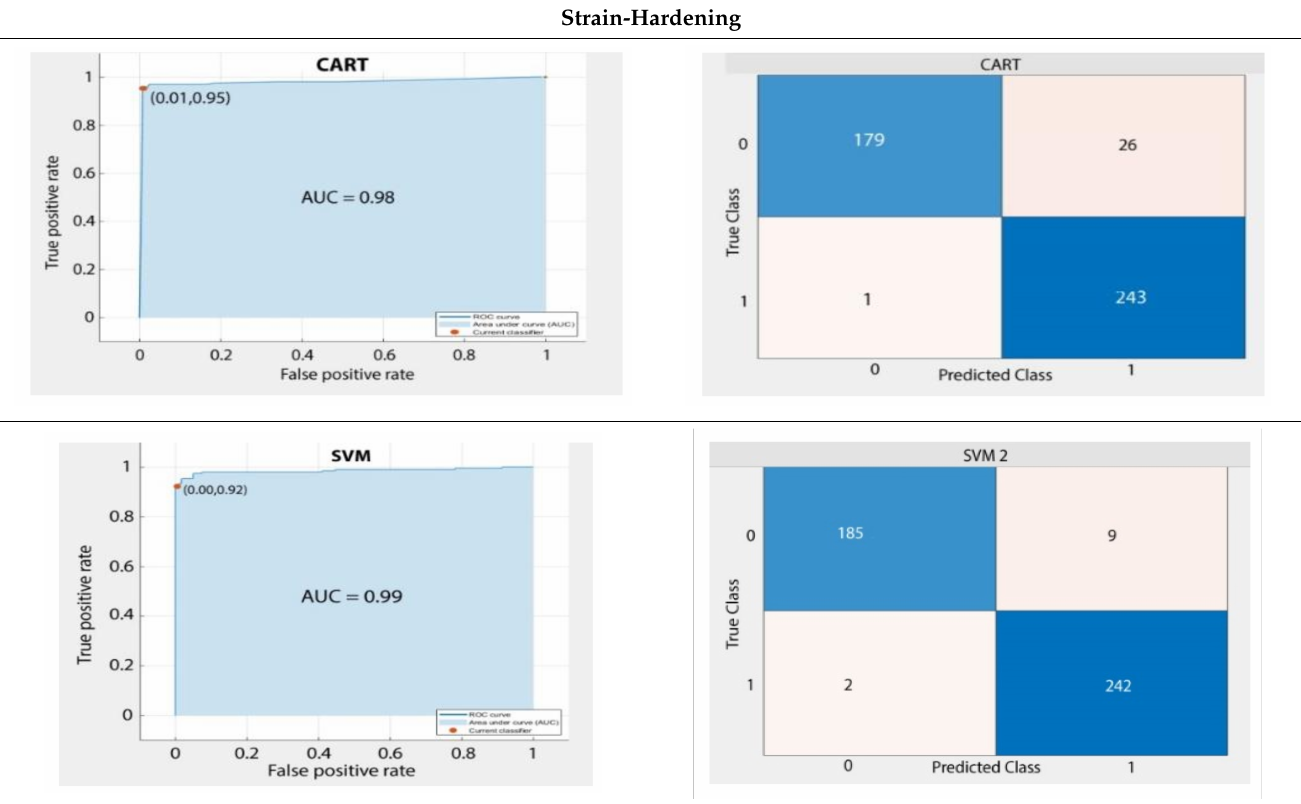
Table 5. AUC and Confusion matrix for predicting Post-cracking